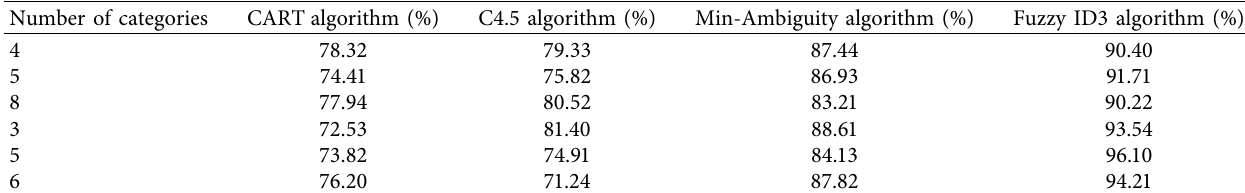
Table 2: Comparison of classification accuracy of the four